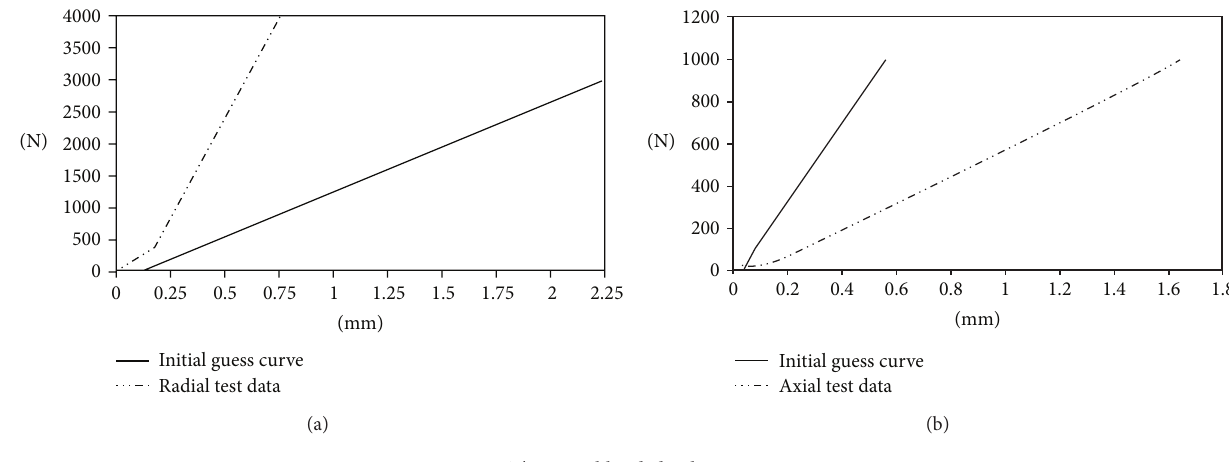
Figure 4: The initial load-displacement curves.